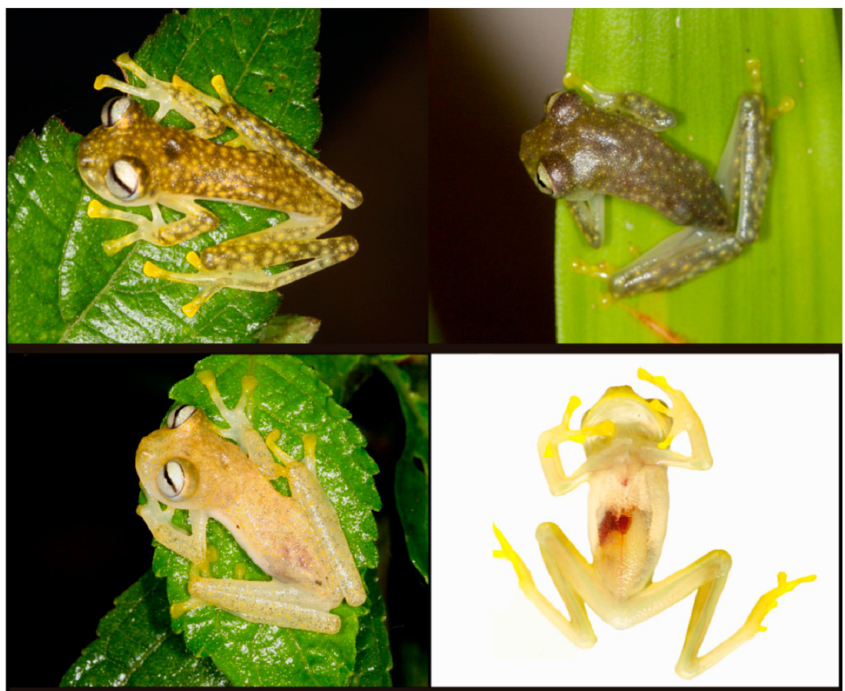
Figure 145. Nymphargus colomai sp. nov. in life from stream nearby Miazi Alto, Zamora Chinchipe province, Ecuador. ( Top left ): QCAZ 41590, holotype; other frogs are part of the type series. Photos by Holger Braun and Juan M. Guayasamin.